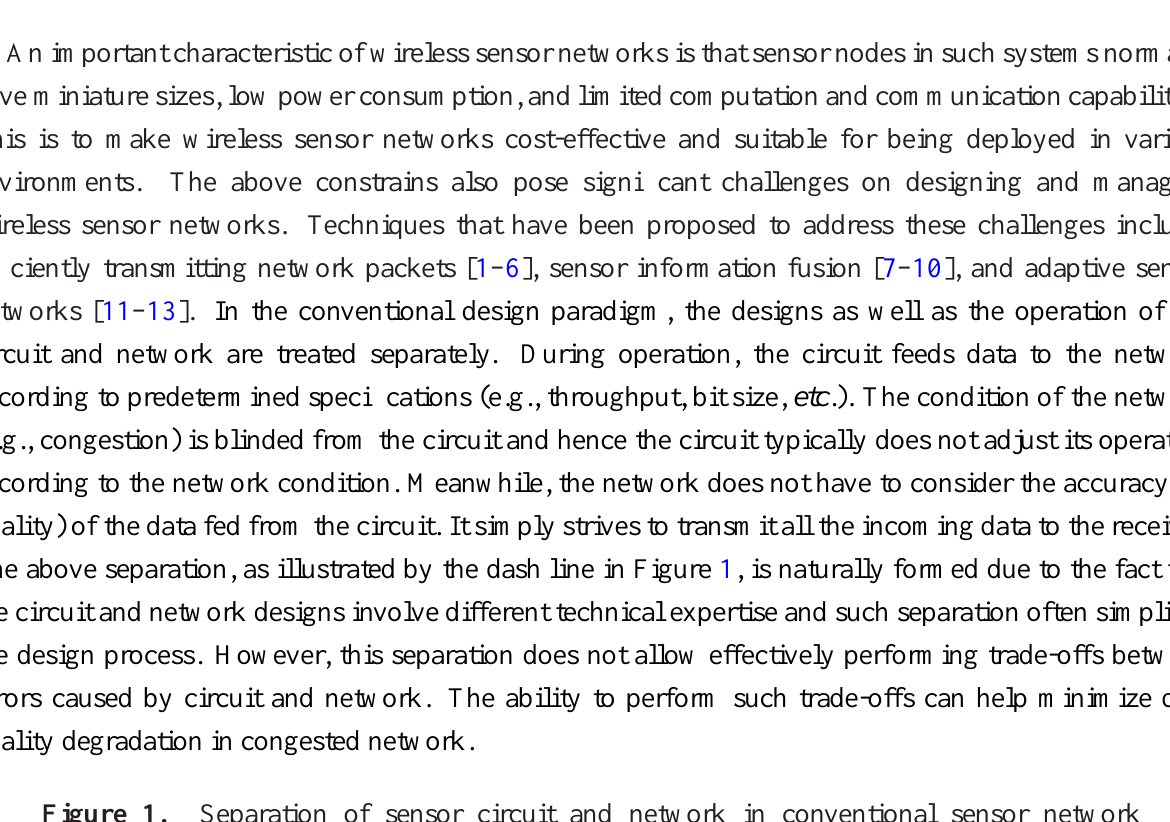
Figure 1. Separation of sensor circuit and network in conventional sensor network design